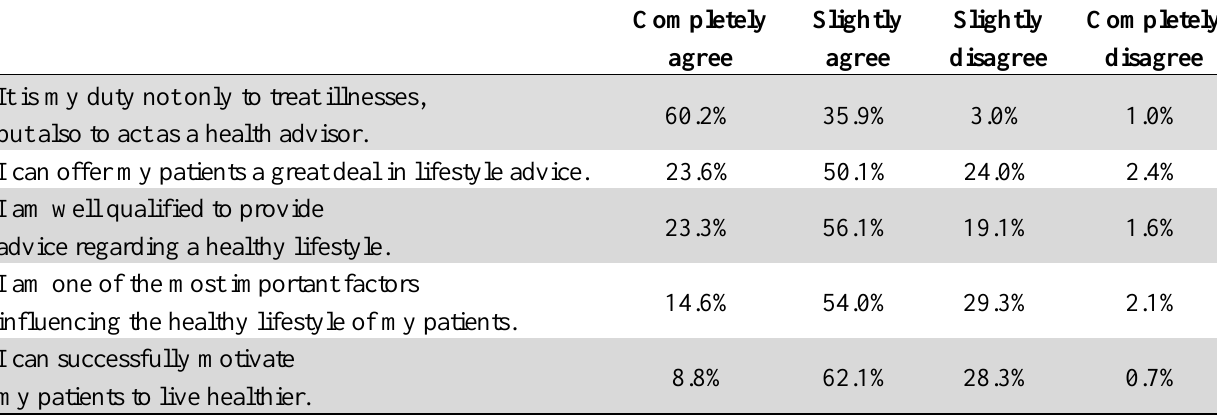
Table 2. Attitudes, self-competence, and self-efficacy of PCPs towards health promotion and CVD prevention (Agreement with statements in % of